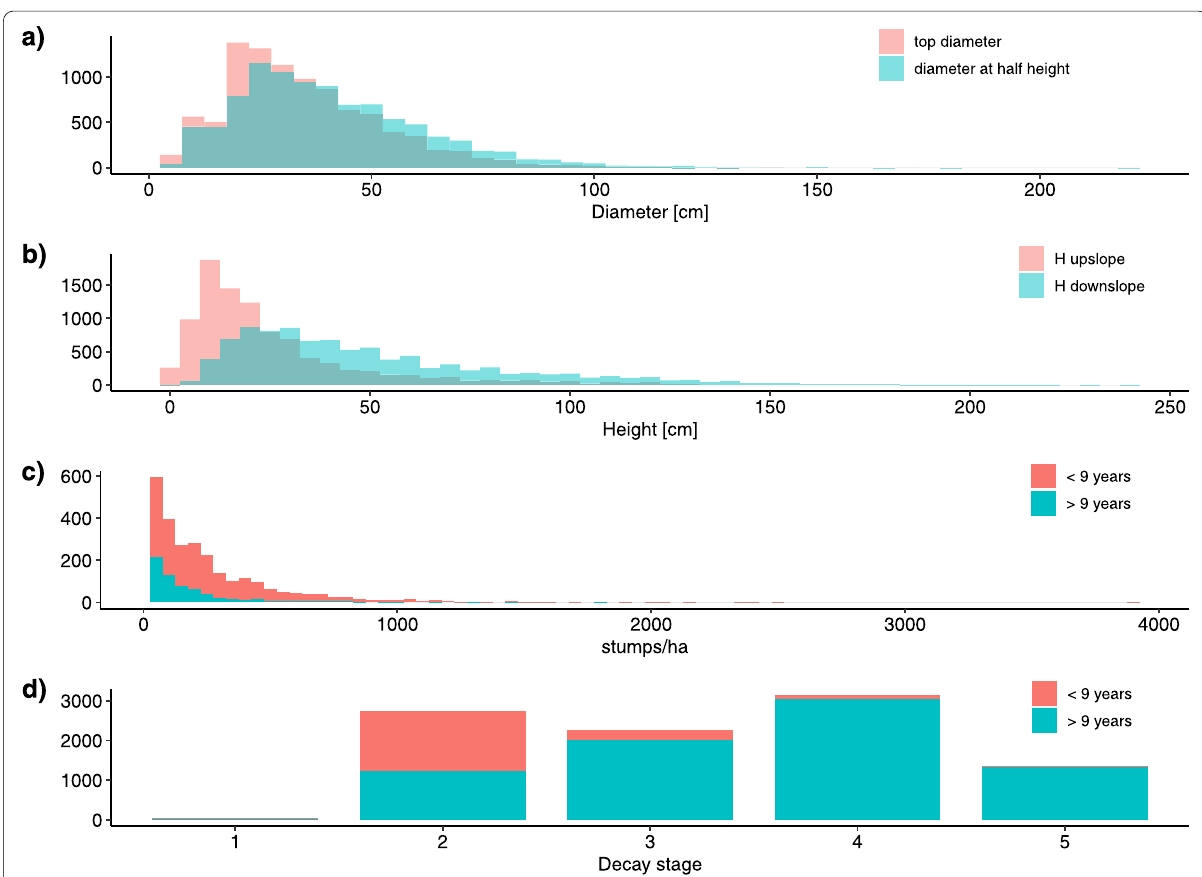
Fig. 4 Frequency distribution of top diameter, diameter at half the downslope height, height on upslope facing side, height on downslope facing side, decay stage, and stumps per hectare for data from the stump inventory in the NFI5. Decay stage and stumps per hectare are shown for recent stumps that originated from tally trees in the NFI4 and for old stumps that existed as stumps for more than 9 years, i.e., before the